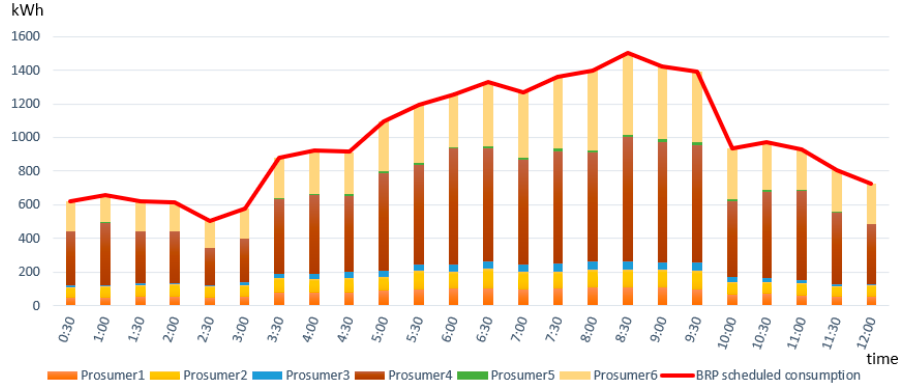
Figure 7. Balancing Responsible Party (BRP)’s scheduled energy plan in relation with enrolled prosumers energy consumption.